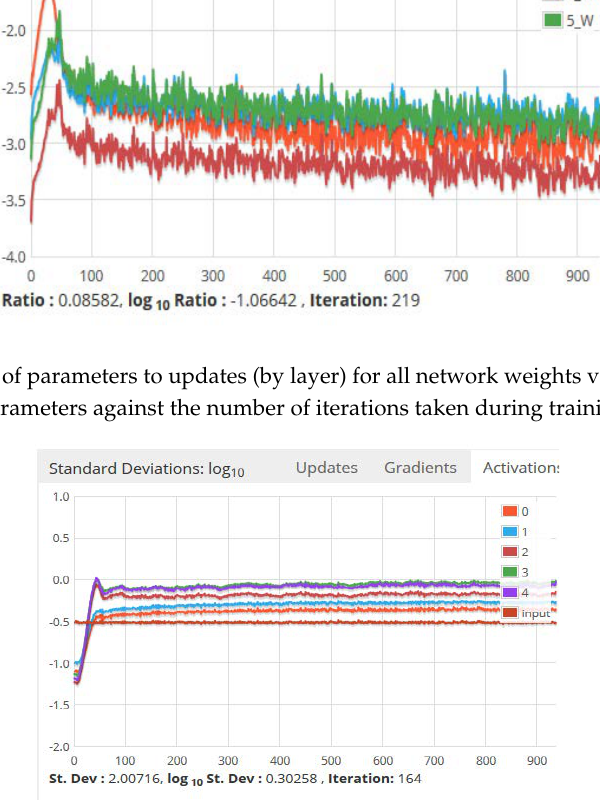
Figure 19. Standard deviations of the activations, gradients and updates versus time. Updates refer to the update of the training parameters such as momentum and learning rate parameter.